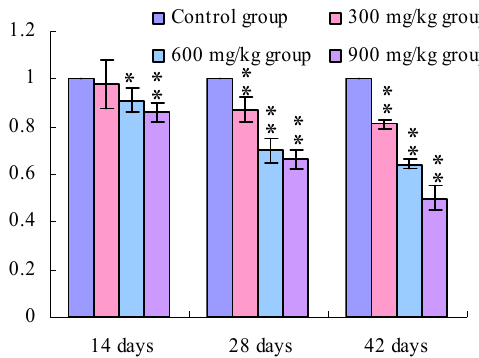
Figure 4. The TLR2-2 mRNA expression levels in the cecal tonsil in broilers.